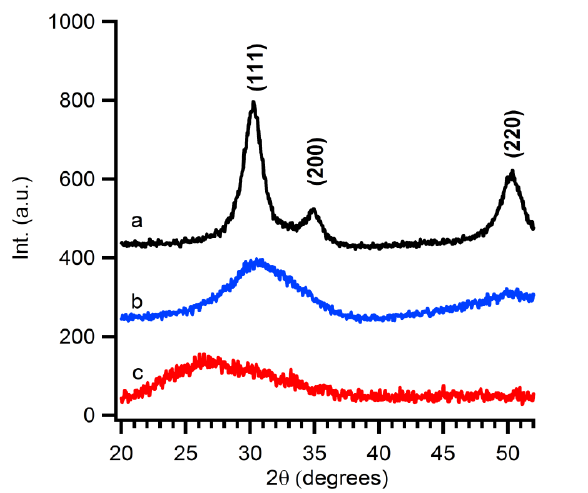
Figure 9. The influence of thermal processing on the crystallinity of the YSZ nanoparticles shown by XRD measurements ( a ) treated at 600 °C for 1 h; ( b ) treated at 400 °C for 1 h; and ( c ) as-synthesised.